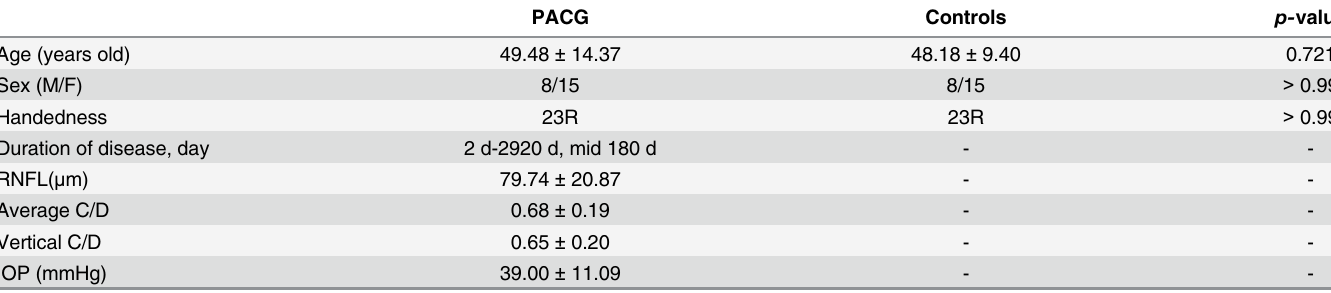
Table 1. Demographics and clinical characteristics of PACG patients and controls.